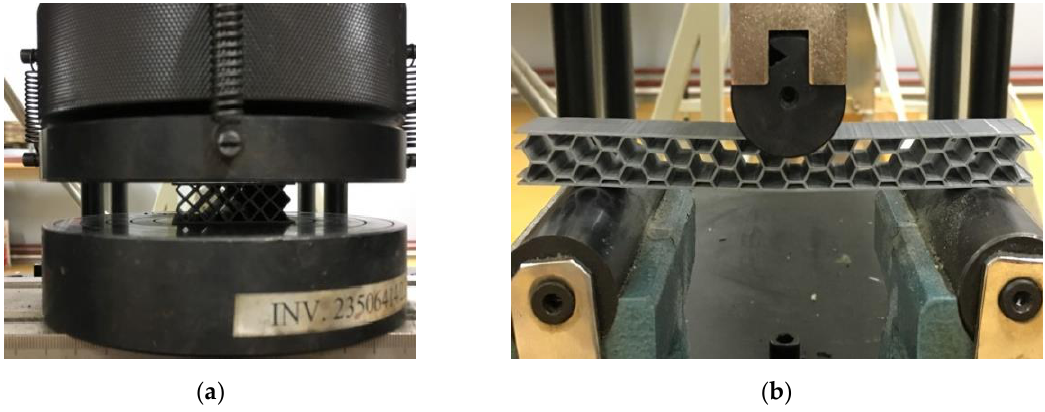
Figure 3. The mechanical tests: ( a ) compression testing of diamond-celled core sandwich specimens; ( b ) three-point bending testing of honeycomb core sandwich structures.